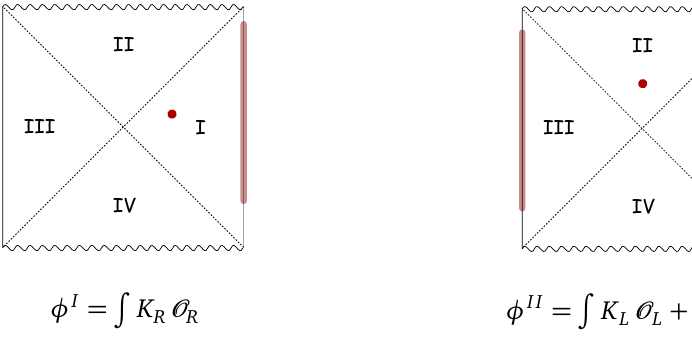
Figure 1: Naïve representation of a charged scalar in regions I, II of the eternal black hole in terms of smeared CFT operators on the two